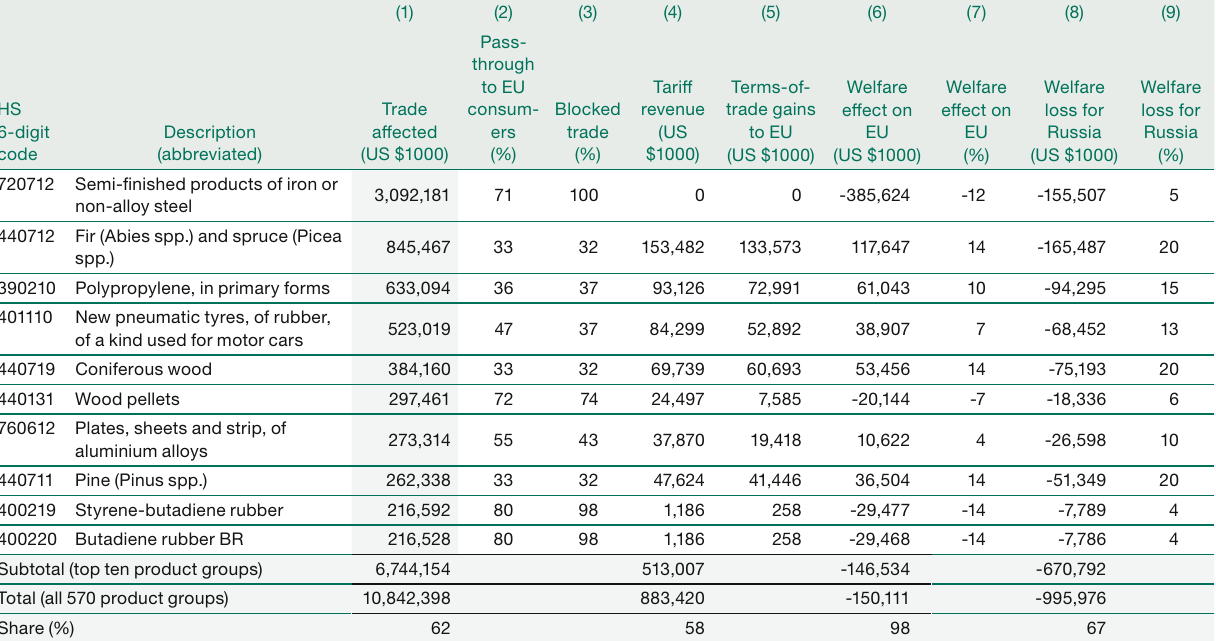
Top ten economically signifi cant sectors and their eff